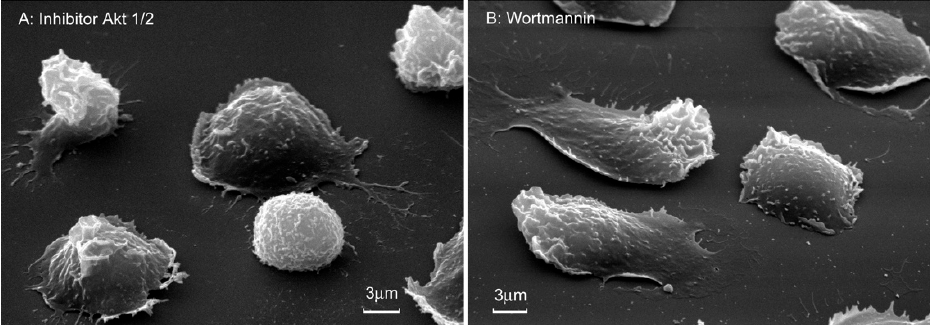
Figure 6. Morphology of neutrophils attached to fibronectin in the presence of inhibitors of the PI3K/Akt pathway. Scanning electron microscopy images of human neutrophils that were attached to fibronectin coated substrates for 20 min in the presence of 25 µM Akt 1/2 inhibitor ( A ) or 1 µM wortmannin ( B ). Images are typical images observed in three independent experiments.